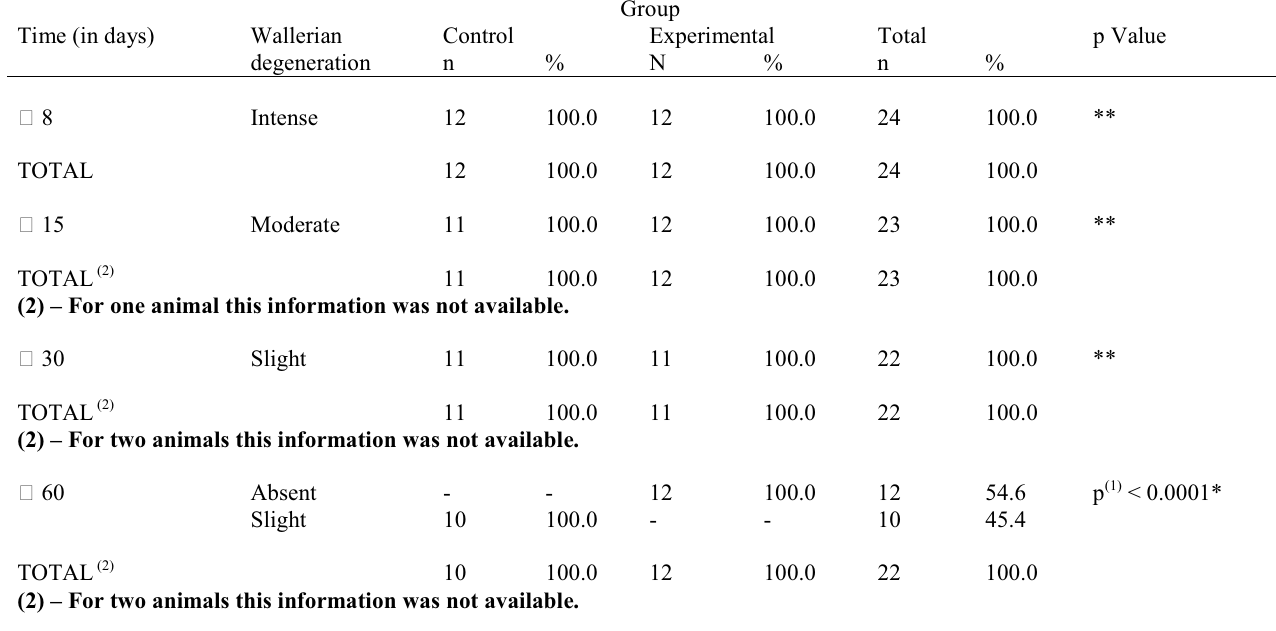
TABLE 3 – Evaluation of Wallerian degeneration in control and experimental groups at 8, 15, 30 and 60 days